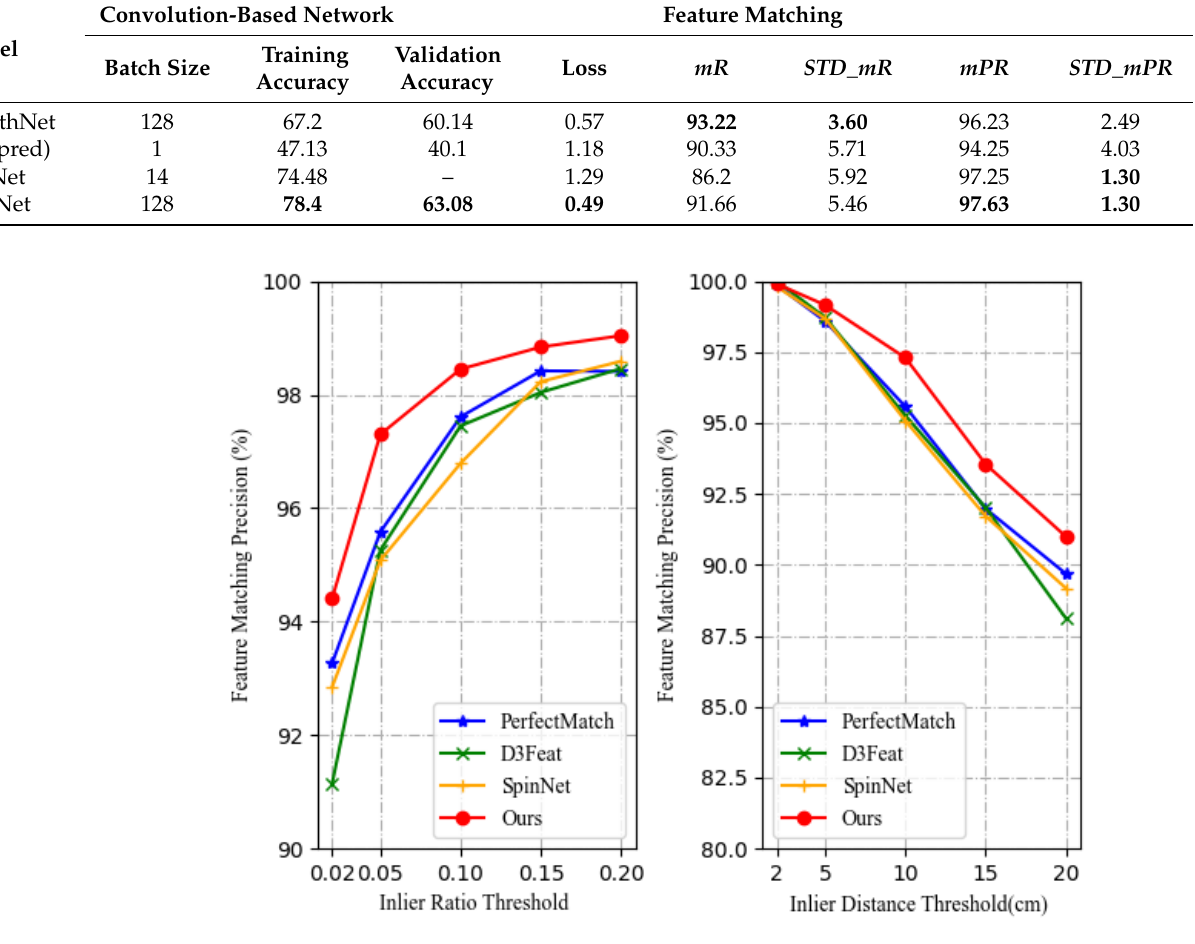
Figure 7. Feature matching precision on 3DMatch test set under different inlier ratio threshold ( left ) and inlier distance threshold ( right